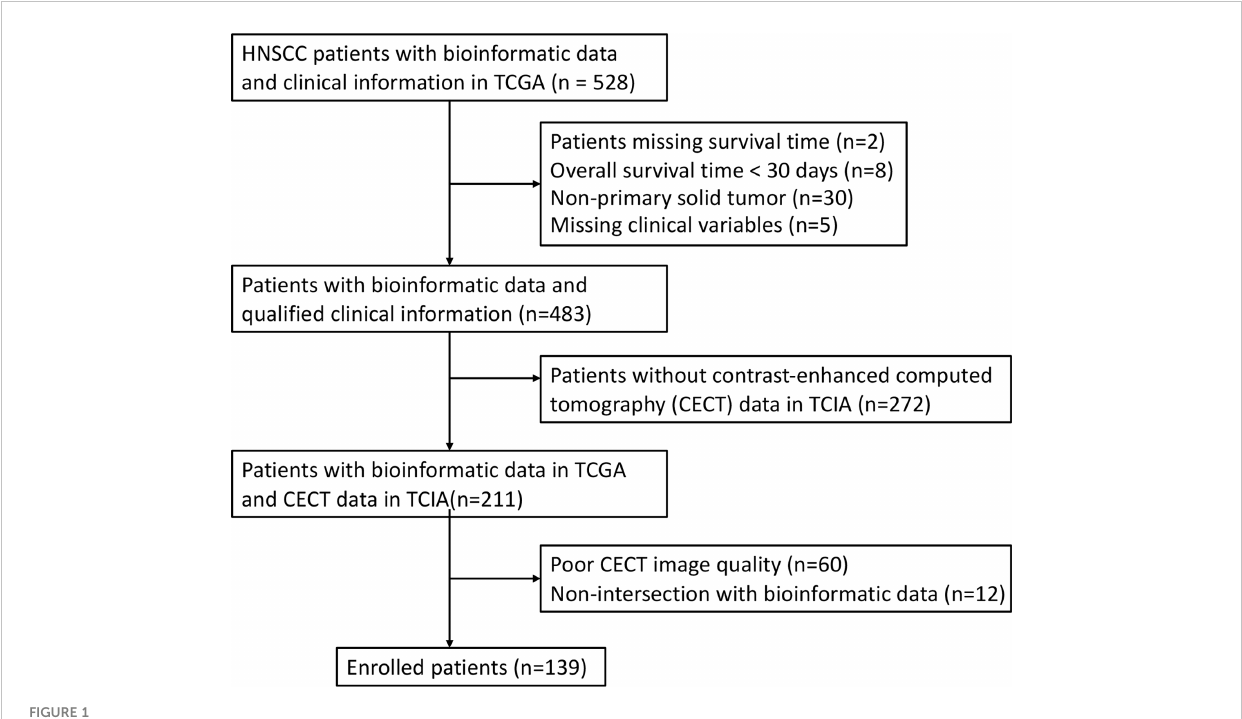
FIGURE 1 The Inclusion and Exclusion Procedure of the patients with